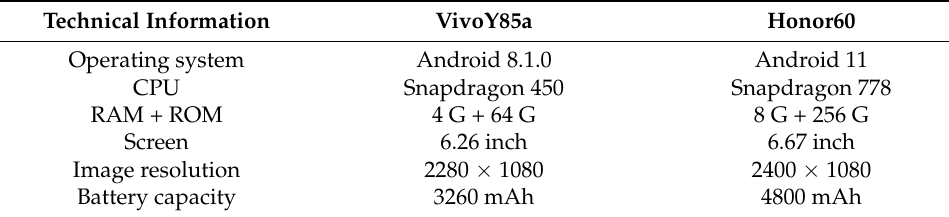
Table 1. Mobile phone technical information.